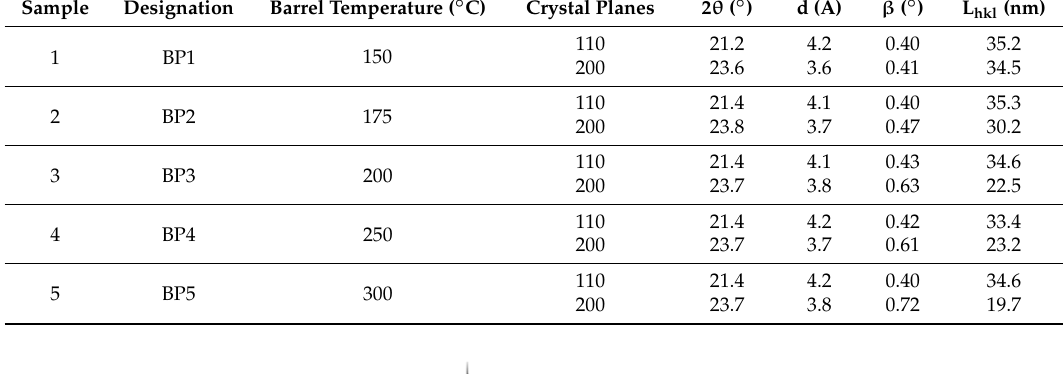
Table 7. Summary of the parameters retrieved from the X-ray diffraction (XRD) curves. Sample